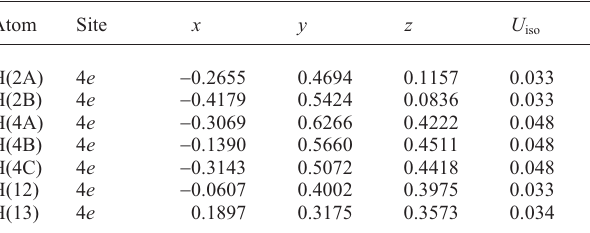
Table 2. Atomic coordinates and displacement parameters (in Å 2 ) .